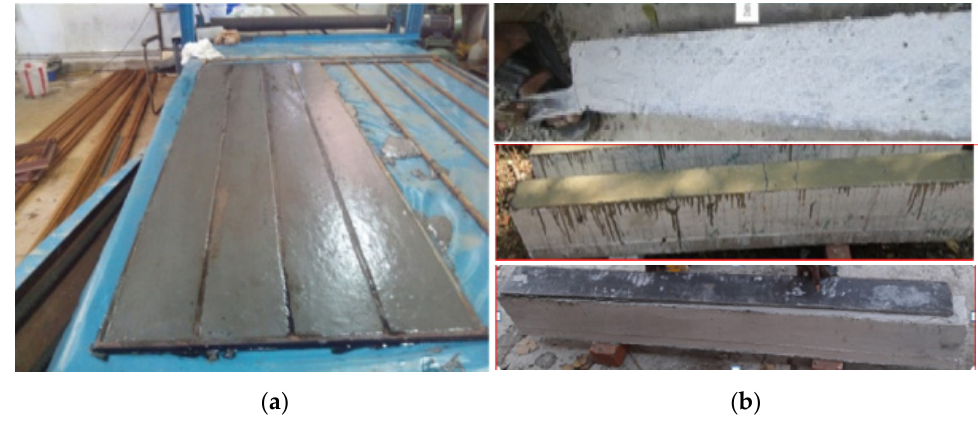
Figure 9. Strengthening of RC beams using UHPFRC strips. ( a ) Prefabrication of UHPFRC strips and ( b ) surface preparation and epoxy adhesive bonding of UHPFRC strips ([84]—Elsevier Copy- right). Table 2. Summary of the studies on flexural strengthening using UHPFRC.